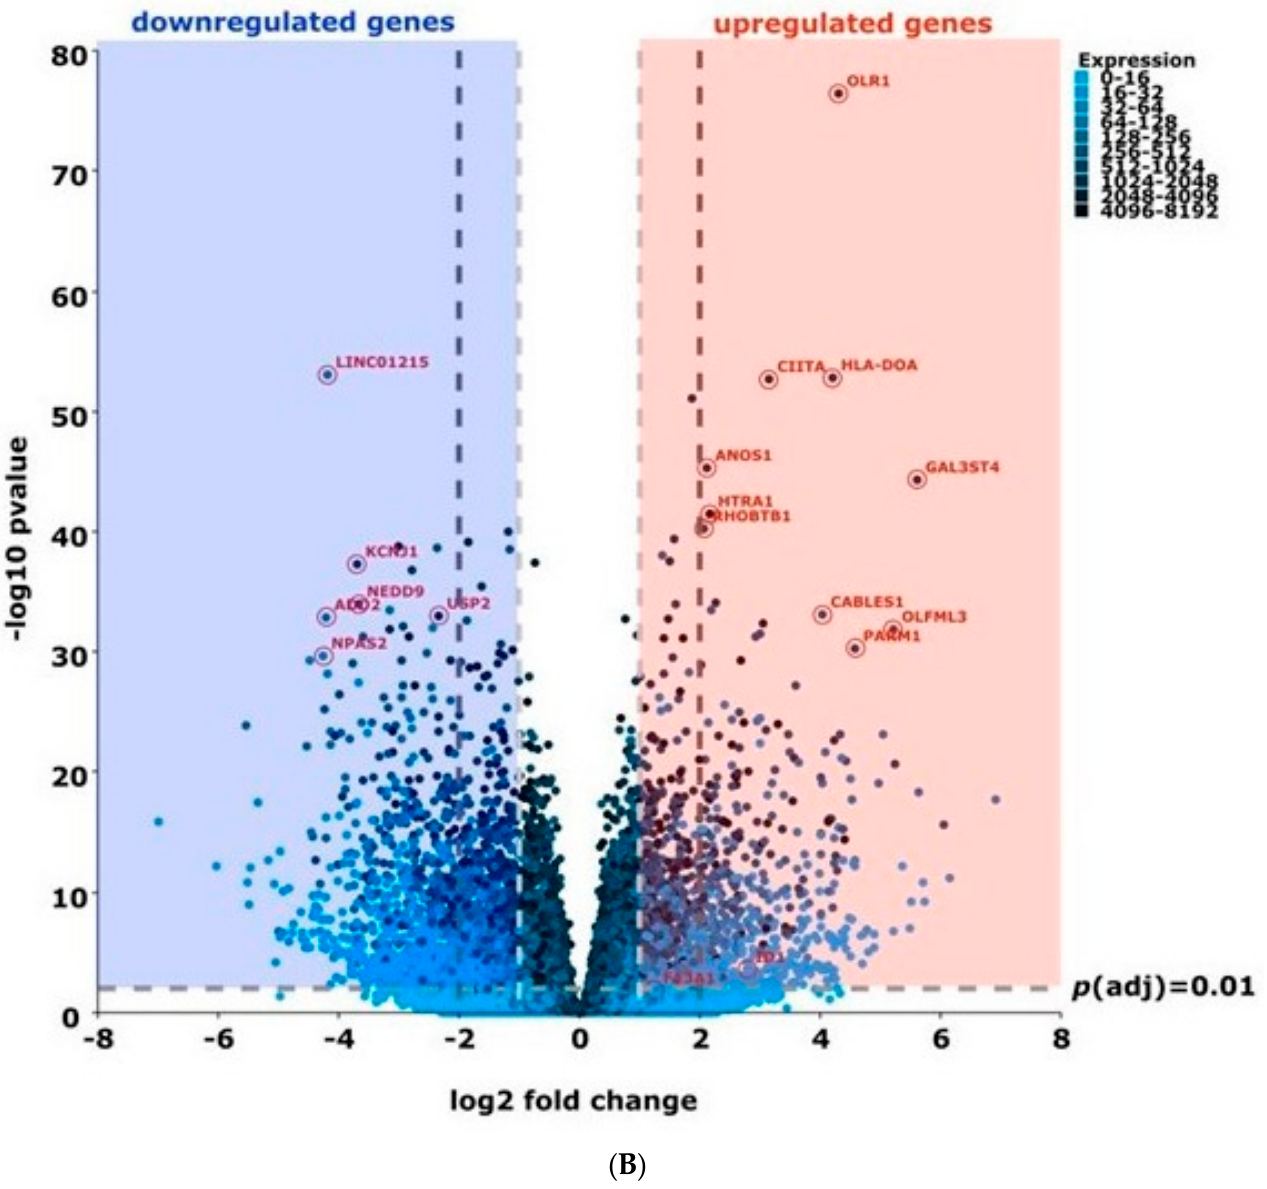
Figure 6. Activin-A-induced differential gene expression. Activin-A-induced DEGs with p (adj) < 0.01, Log2 fold change ≥ 2. ( A ) Heatmap showing the 100 most significant DEGs under the influence of Activin-A. ( B ) Volcano plot showing the upregulated and downregulated genes under the influence of Activin-A, plotted as the Log2 fold change ( x -axis) versus the statistical significance ( y -axis). Annotated dots are the genes confirmed by qPCR (see Figure 7).